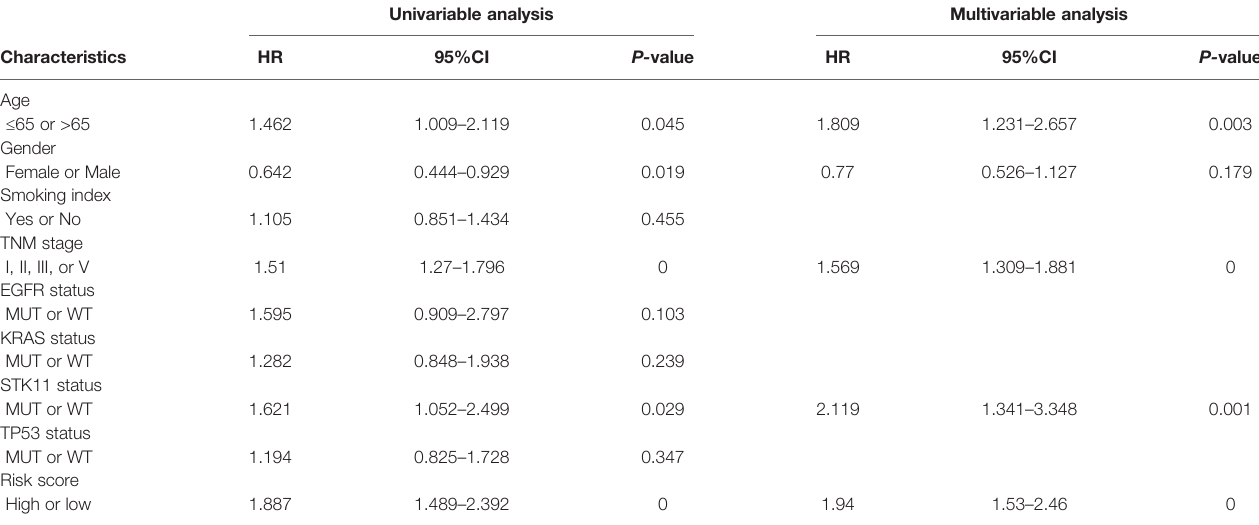
TABLE 1 | Univariate and multivariate Cox regression analysis for three-TMEM-based signature and clinical features in TCGA